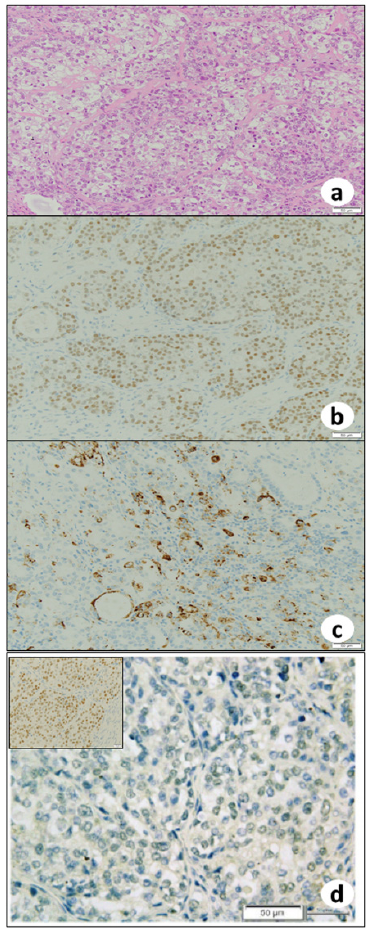
Figure 3. Histopathologically, carcinoma components include ( a ) clear cell carcinoma with compact nests and sheets of cells. Clear cell carcinoma showing diffuse nuclear positivity against ( b ) anti- PAX8 and ( c ) anti-napsin A antibodies. ( d ) There is no nuclear stainability of ARID1A in clear cell carcinoma. ( a ) Hematoxylin and eosin staining; ( b ) PAX8 immunohistochemistry; ( c ) napsin A immunohistochemistry; and ( d ) ARID1A immunohistochemistry. ( a – d ) bar = 50 µ m. Insert in ( d ) is positive control of ARID1A.